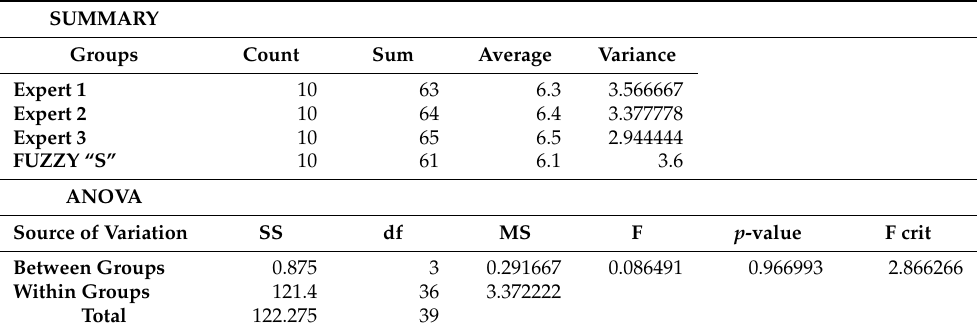
Table 6. ANOVA: single Factor for fuzzy severity.